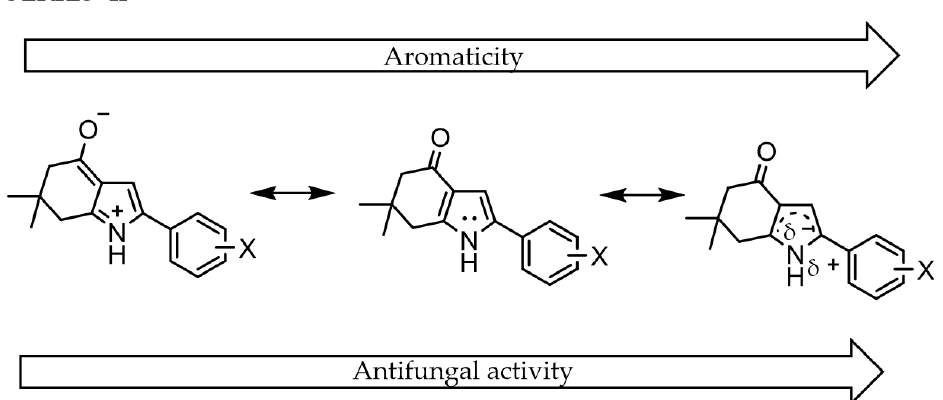
Scheme 2. Trend for the antifungal activity of indol-4-ones for series II ( 8a – g ) vs. NICS(0) and NICS(1). The enolate and keto resonance